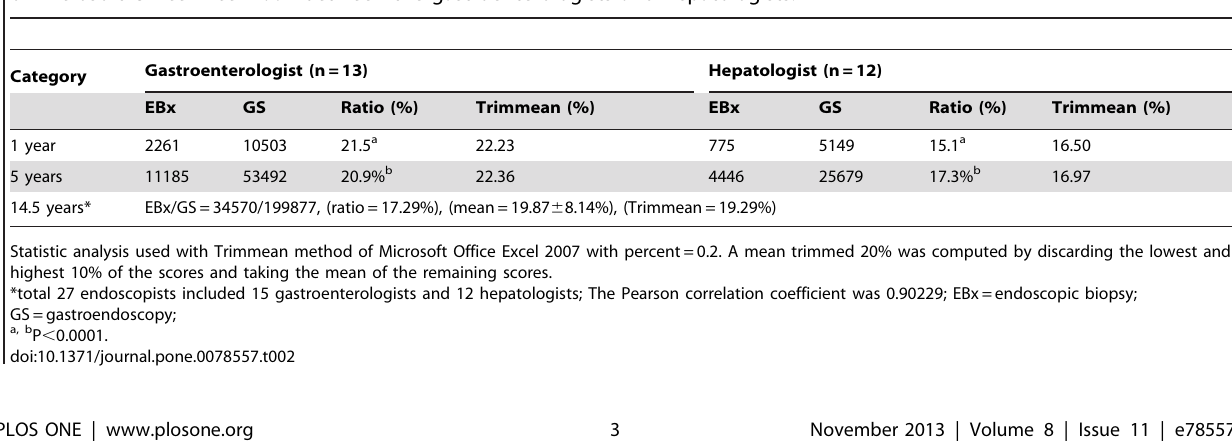
Table 2. The ratio of endoscopic biopsy/gastroendoscopic procedures and Trimmean modified with Trimmean statistical method of Microsoft Office Excel 2007 between the gastroenterologists and